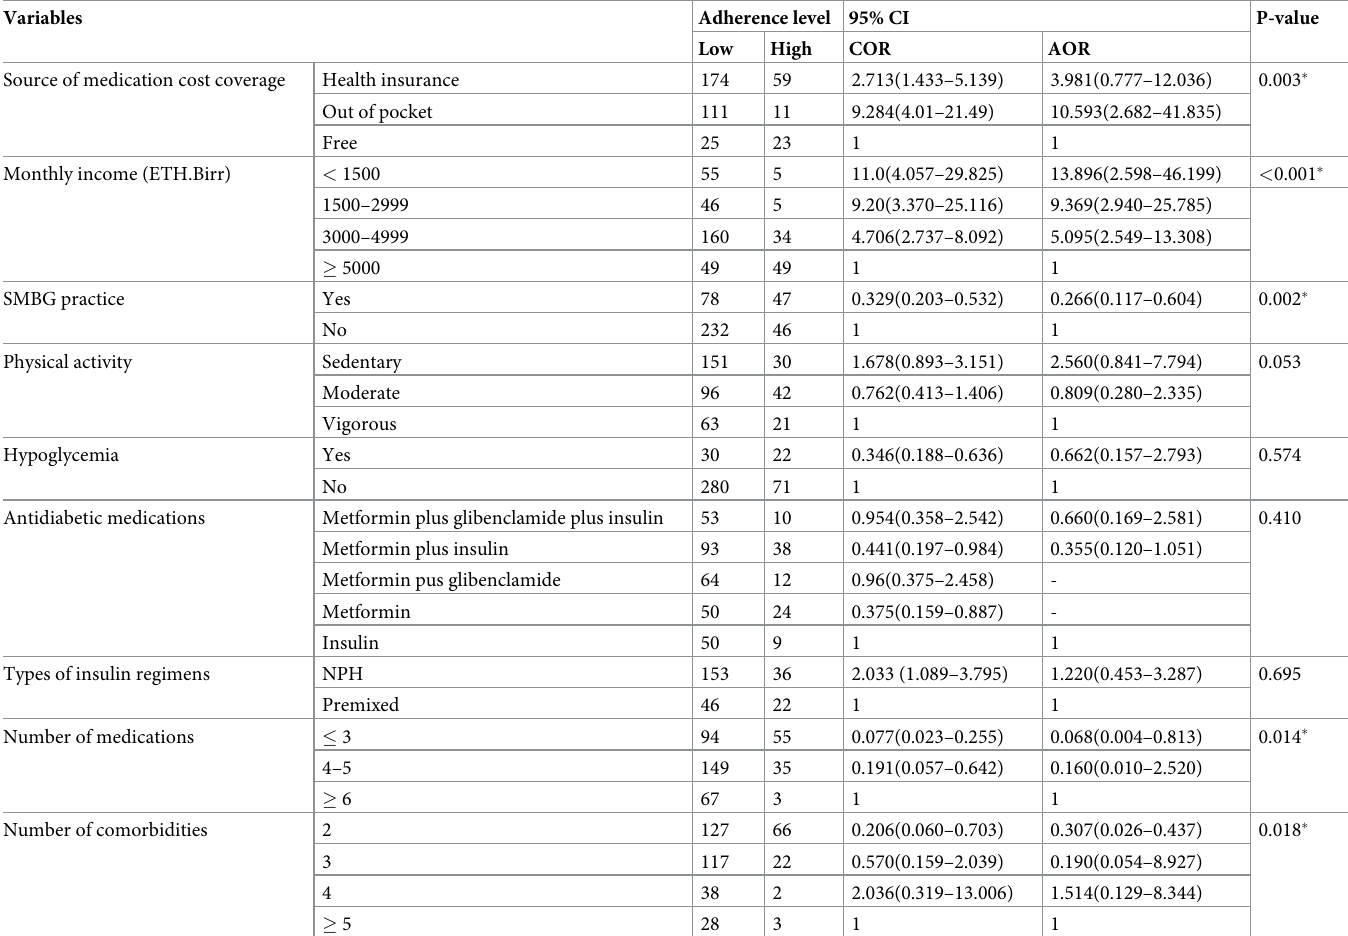
Table 4. Determinants of medication adherence in patients T2DM patients with